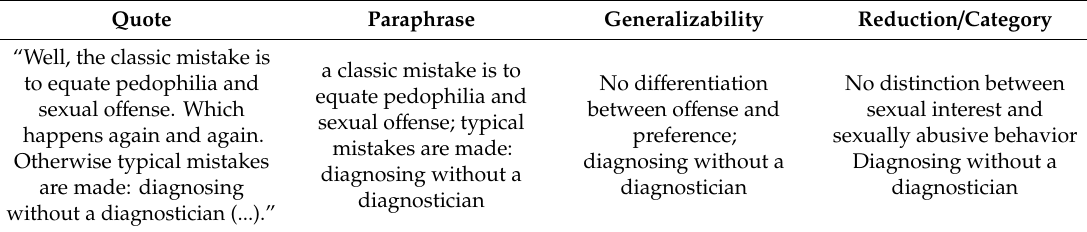
Table 1. Example data